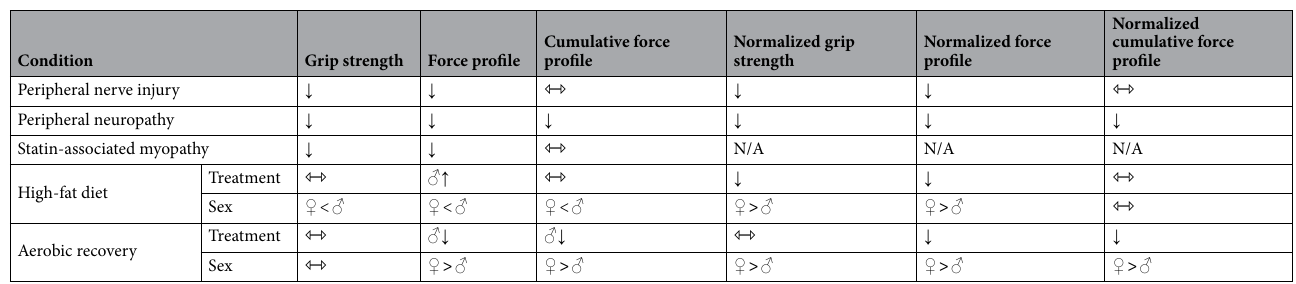
Table 1. Summary of alterations in grip strength, force profile, and cumulative force profile following surgical, pharmaceutical and dietary interventions. ↓ , decrease, ↑ , increase, or ⇿ , unchanged following intervention relative to control. ♂ > ♀ , male values greater than female values; difference following intervention. ♀ > ♂ , female values greater than male values; difference following intervention. ♂↓ Male-specific reduction. ♂ ↑ Male-specific